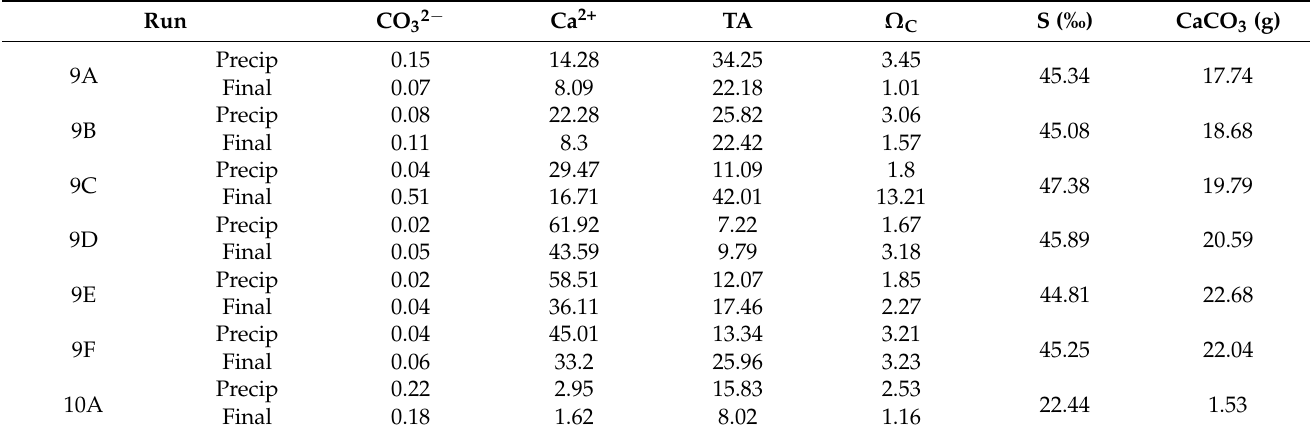
Table 2. Steady-state pH; average salinity; CO 32 − , Ca 2+ , and Mg 2+ aqueous concentrations, precipitation, and final saturation state ( Ω c); and mass of precipitated calcium